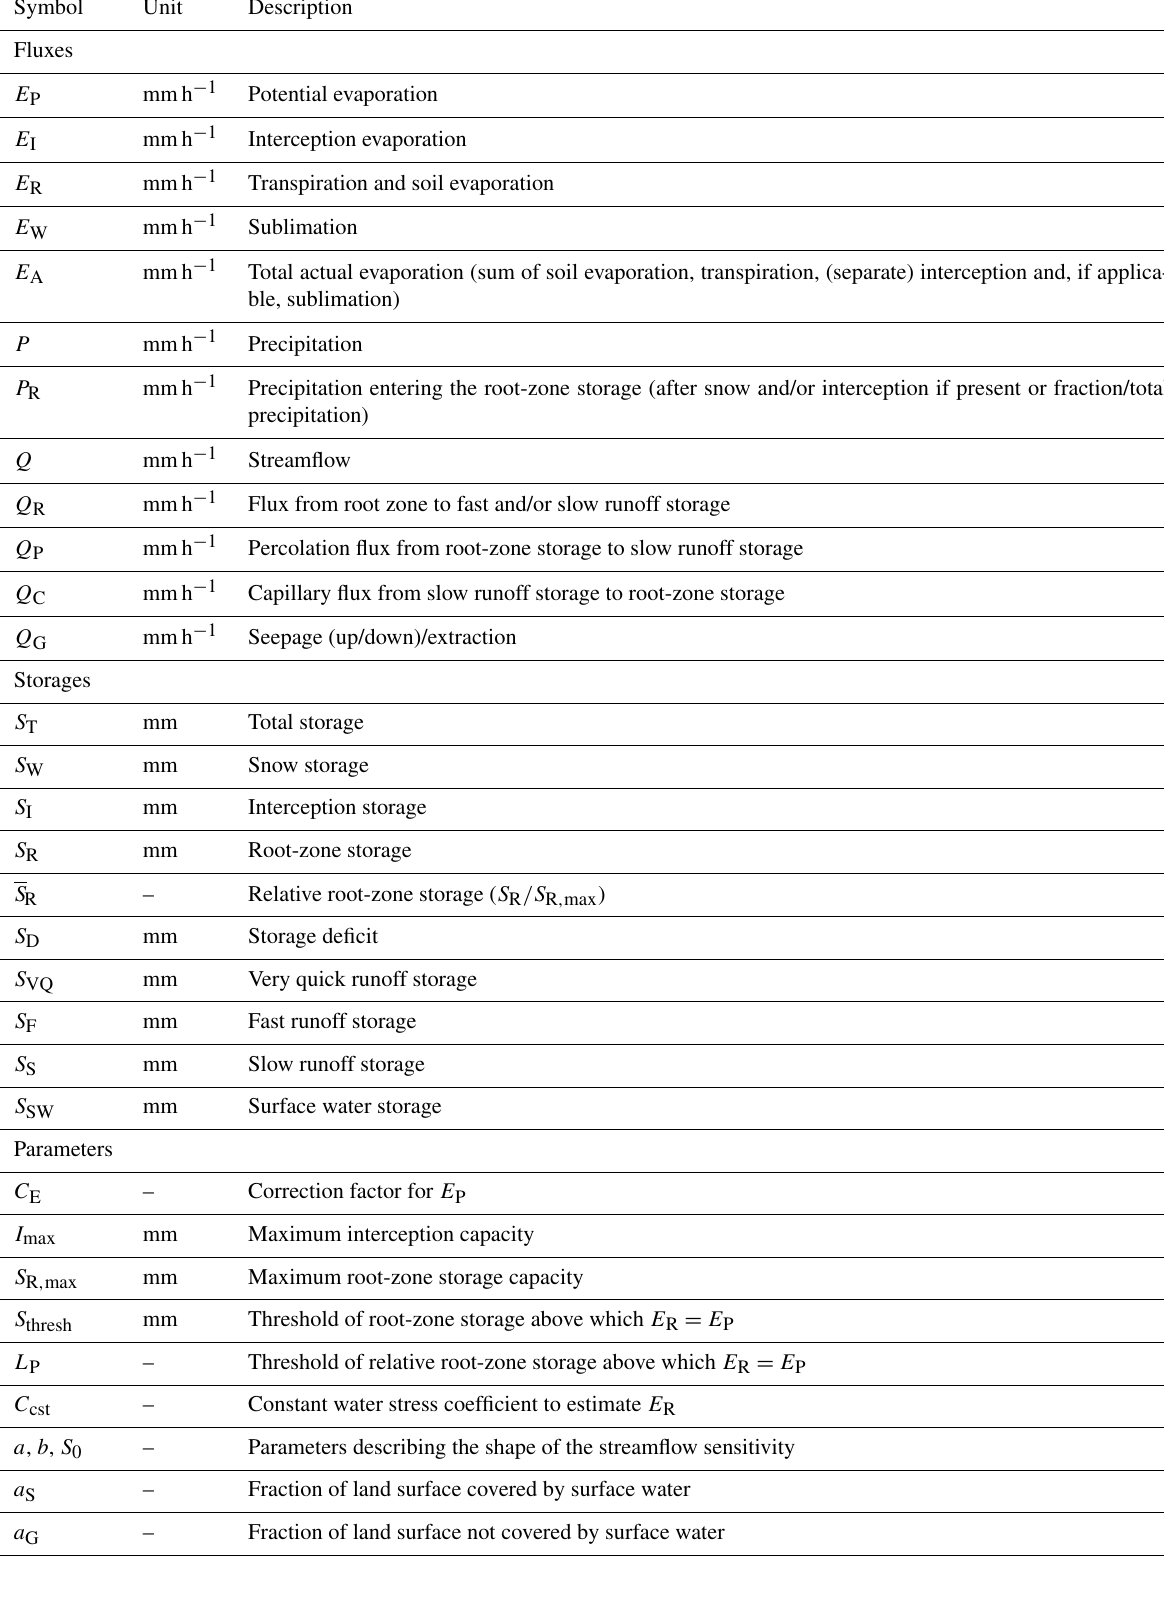
Table 1. Description of symbols used for fluxes, storages and parameters in Tables 2 and 3. Symbol Unit Description